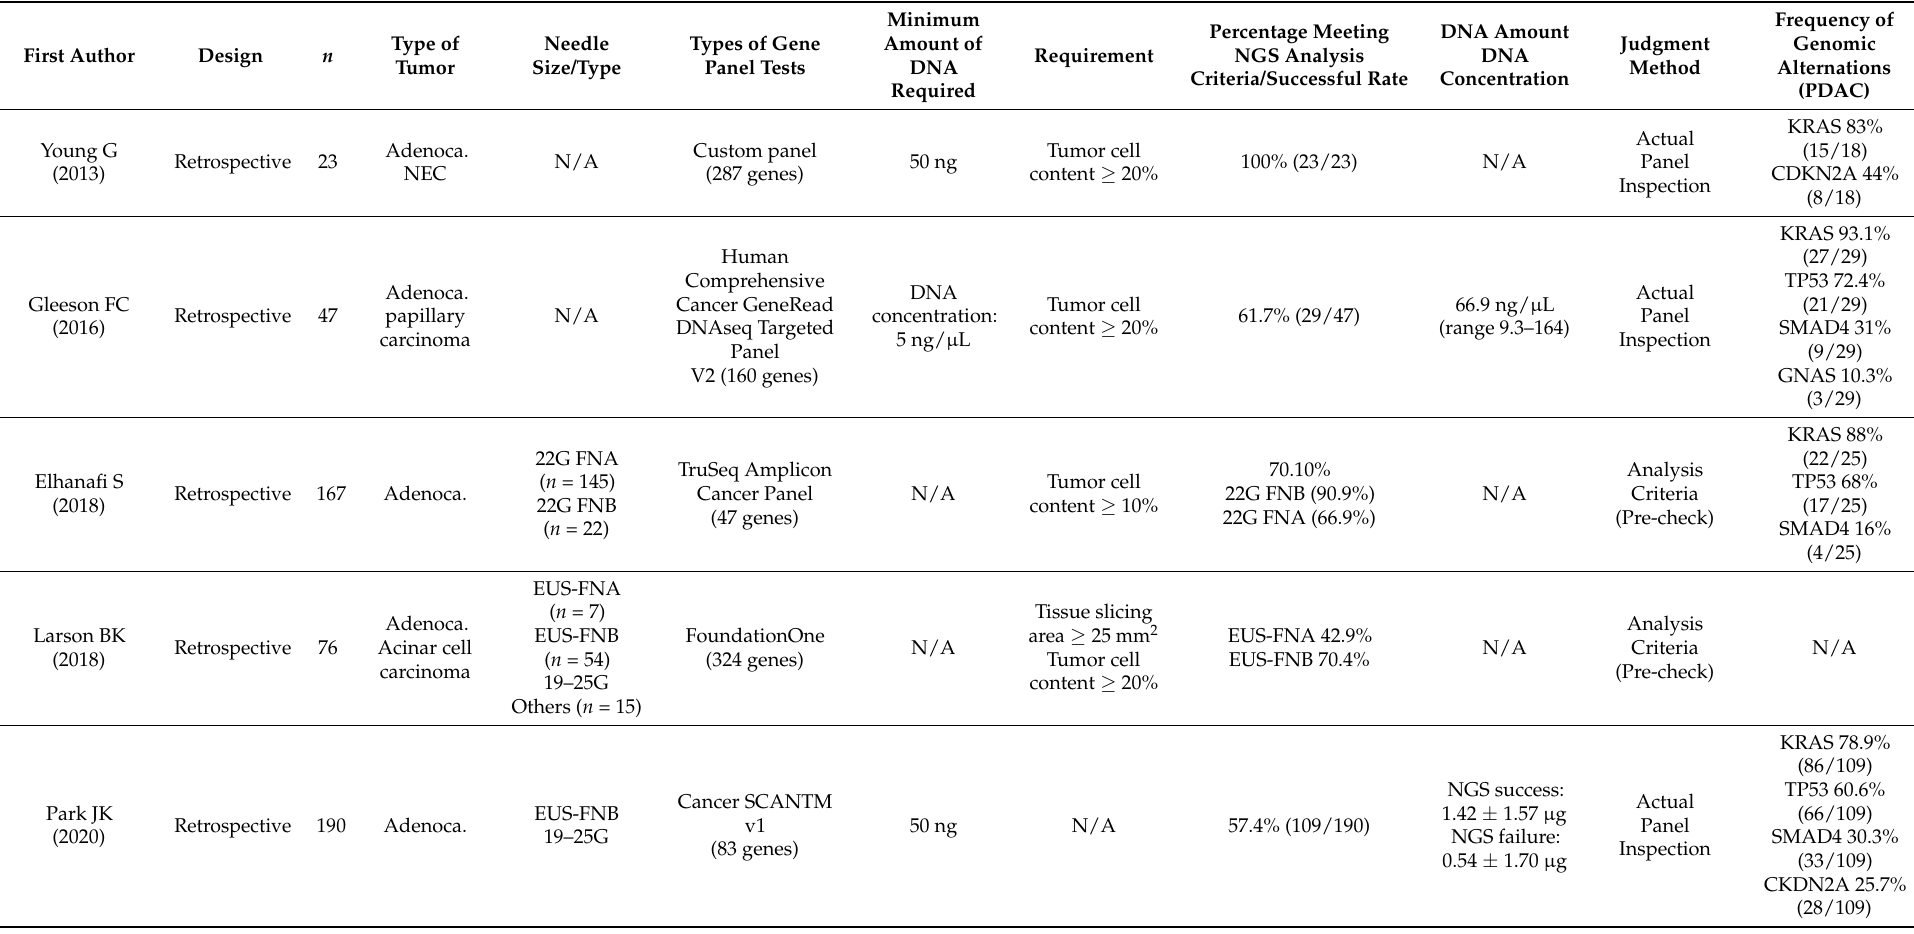
Table 3. Success rate of cancer genomic testing using EUS-TA FFPE for pancreatic